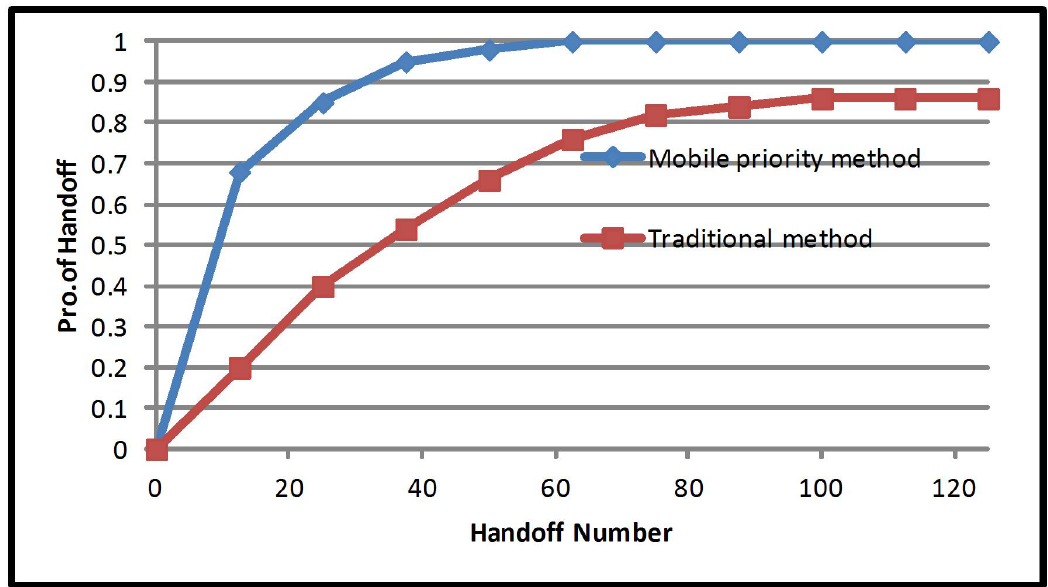
Figure 3. Handoff number probability of the mobile priority